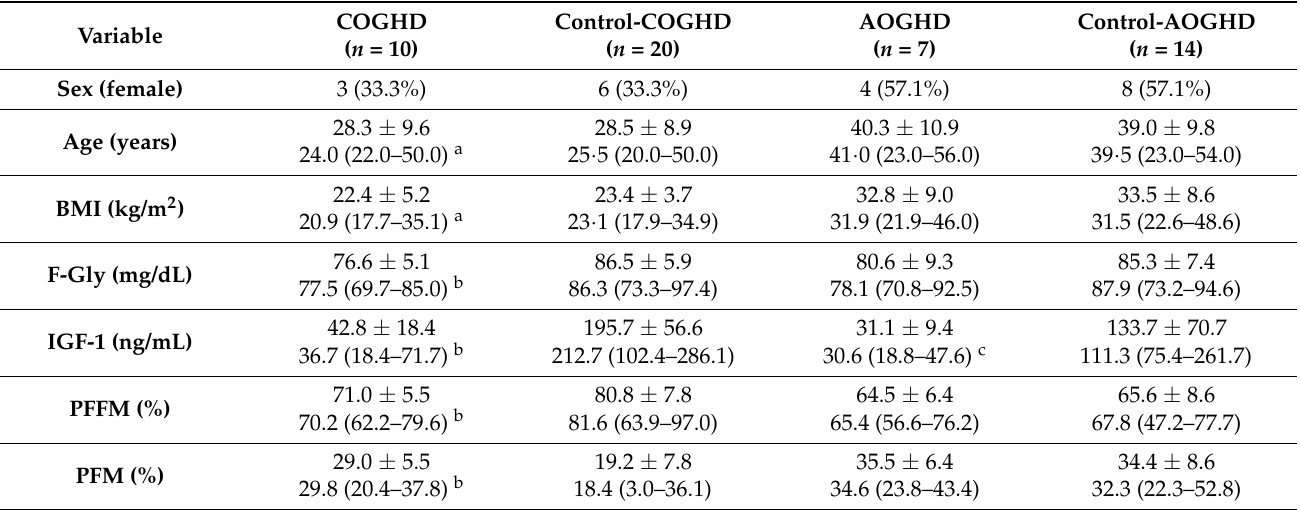
Table 2. Comparative analysis of clinical, laboratory characteristics and body composition between patients with childhood-onset, adulthood-onset GHD, and their respective control subjects.